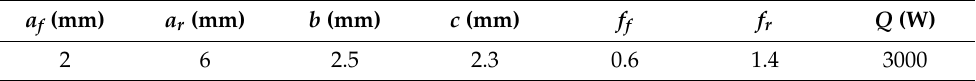
Table 1. The parameters for the double ellipsoidal heat source model used in the present